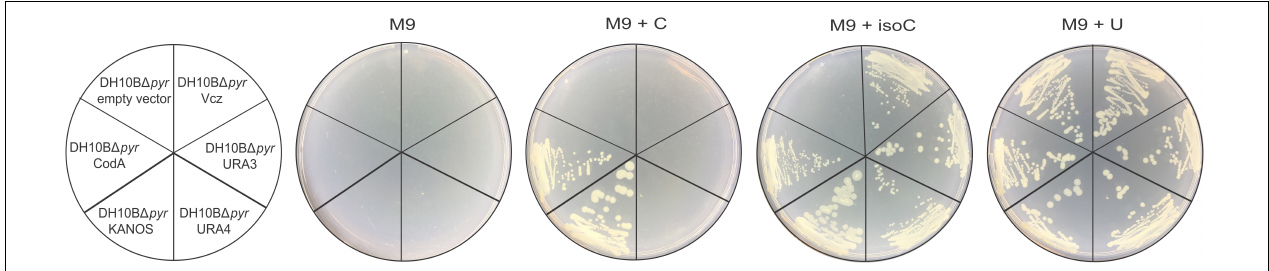
FIGURE 2 | In vivo functionality of E. coli CD (CodA, in pQE70 expression vector) and the DNA fragments that were selected from four metagenomic libraries: KANOS, URA4, URA3, and Vcz (in pUC19 vector). Empty pQE70 vector was used as a negative control. Minimal medium (M9) was supplemented 100 mg/L ampicillin, 15 mg/L kanamycin, 0.1 mM IPTG, and either with 20 mg/L cytosine (M9 + C), isocytosine (M9 + isoC) or uracil (M9 + U, positive control).